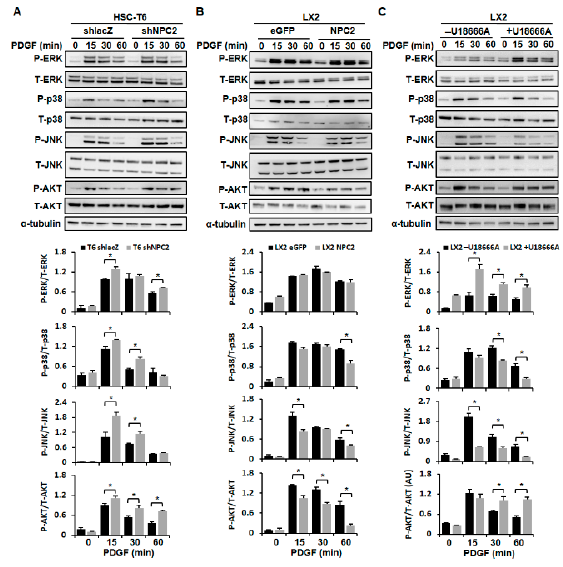
Figure 2. NPC2 downregulation and free cholesterol accumulation in the HSC-enhanced PDGF-BB-initiated MAPK and AKT signaling pathway activation. ( A ) shlacZ and shNPC2 HSC-T6 stable cells; ( B ) eGFP and NPC2 LX2 stable cells were treated with 10 ng/mL PDGF-BB for 0, 15, 30, and 60